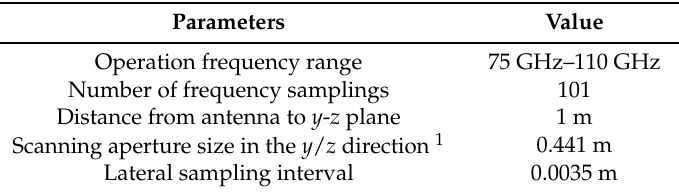
Table 1. The parameters used in